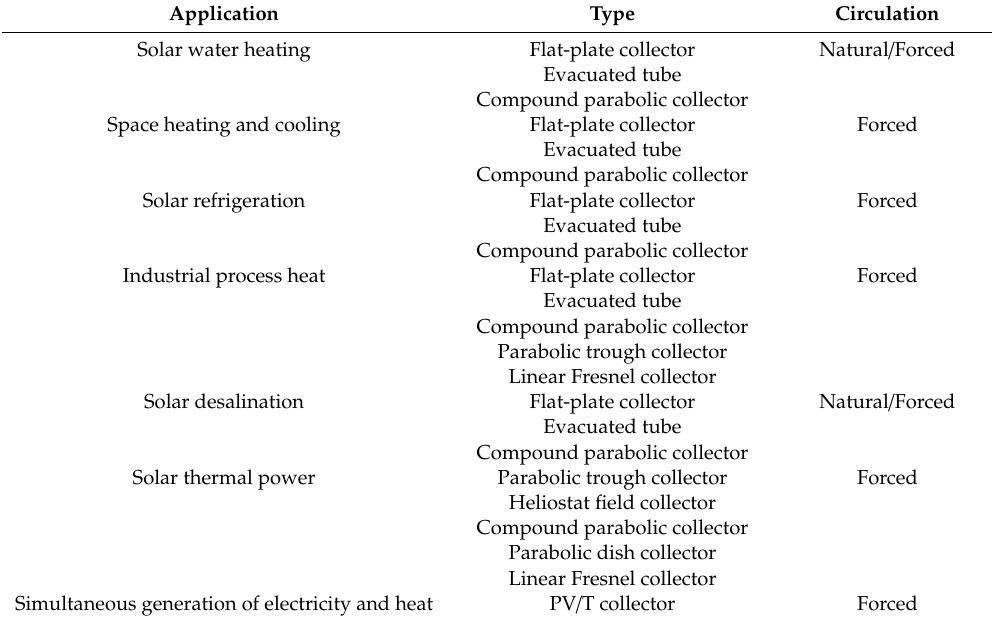
Table 4. Solar thermal collectors for di ff erent applications [71]; 2009,